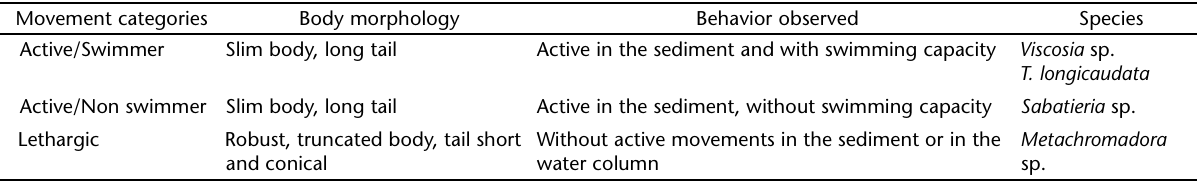
Table IV. Movement categories and their relationship with body morphology and behavior observed in the stained nematodes captured. Movement categories Body